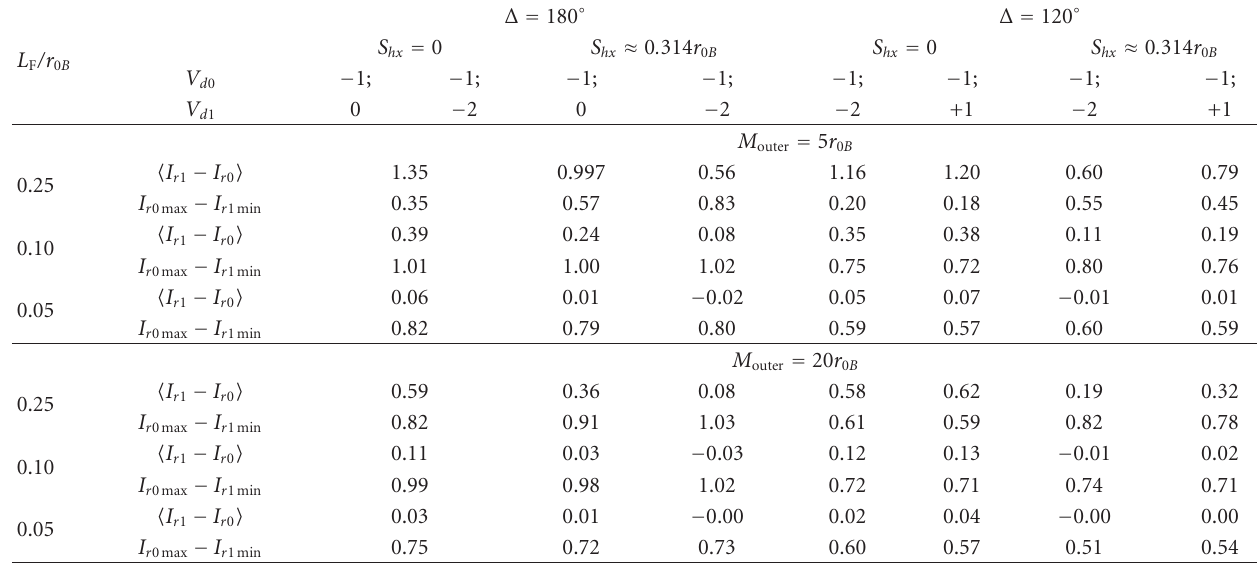
Table 1: Averaged over 13000 realizations mean values of (cid:5) I r 1 − I r 0 (cid:6) and maximum amplitudes I r 0max − I r 1min obtained for pairs ( V d 0 , V d 1 ) with di ff erent Fried’s coherence lengths L F /r 0 B , angles of field rotation Δ , shifts of optical axes S hx , and di ff erent outer scales M outer .